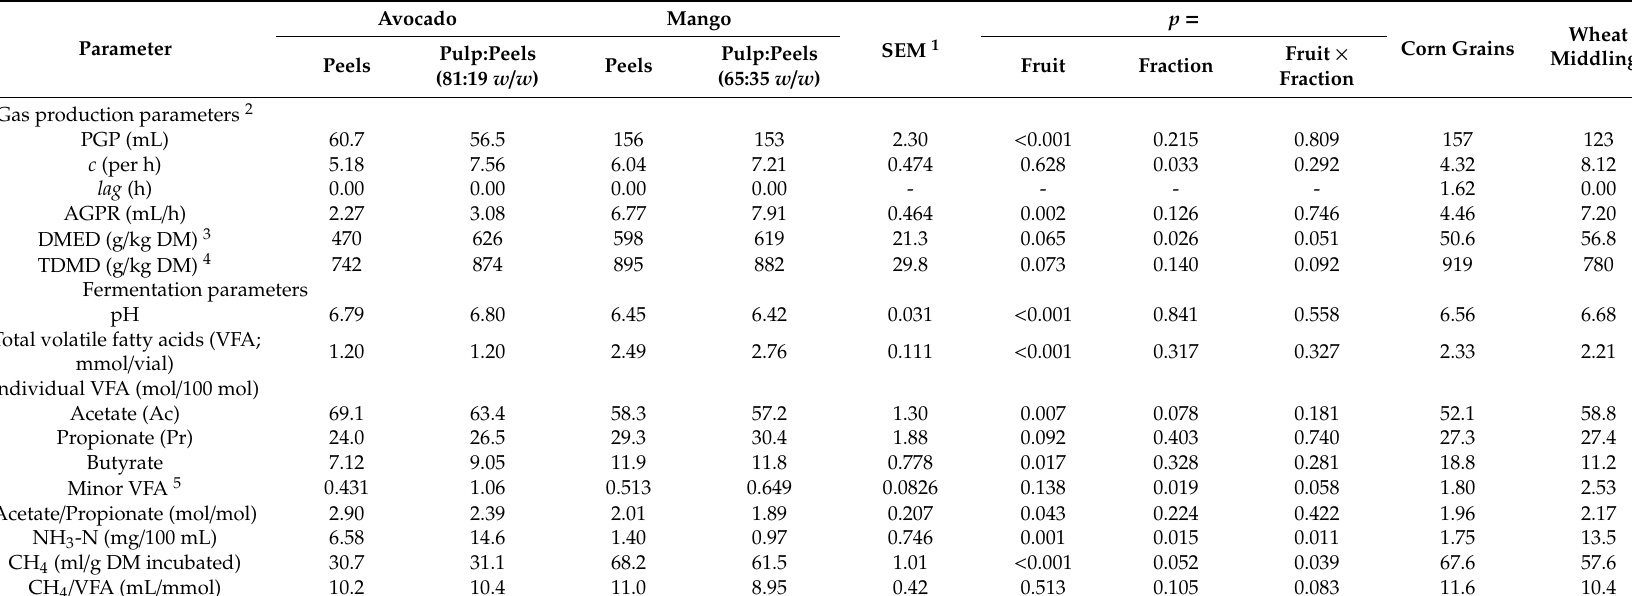
Wheat Corn Grains